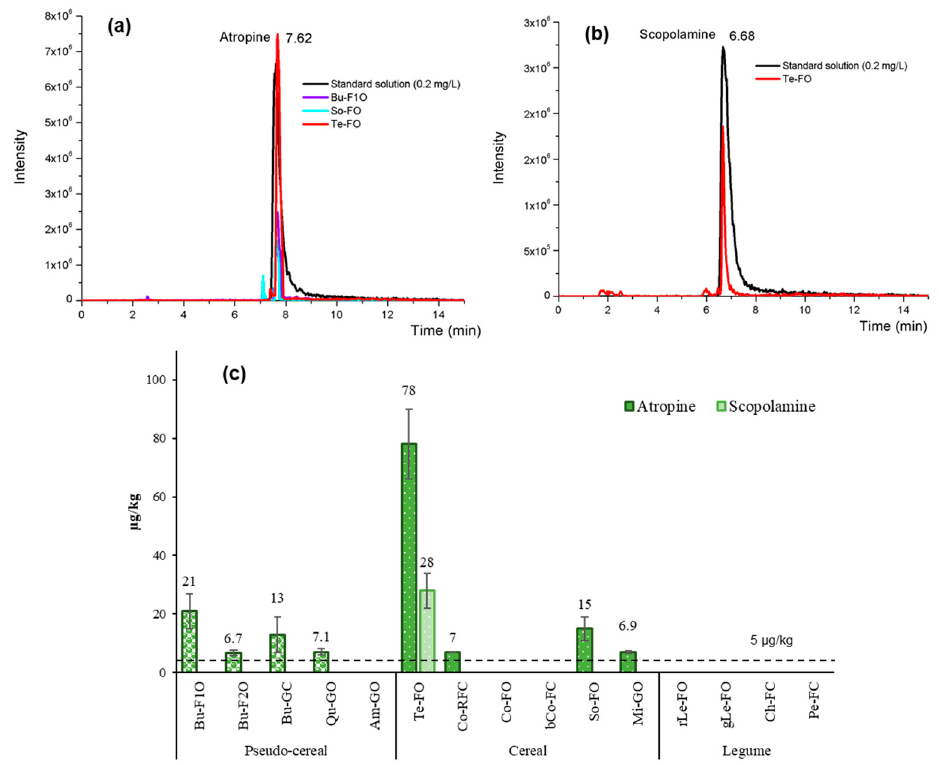
Figure 6. Extracted ion chromatogram of ( a ) atropine (m/z 290.1 > 124.0) and ( b ) scopolamine (m/z 304.1 > 138.0) in a standard solution mixture (0.2 mg/L) and in some positive samples. ( c ) Concentration (µg/kg) of atropine and scopolamine in commercial GF grains and flours.